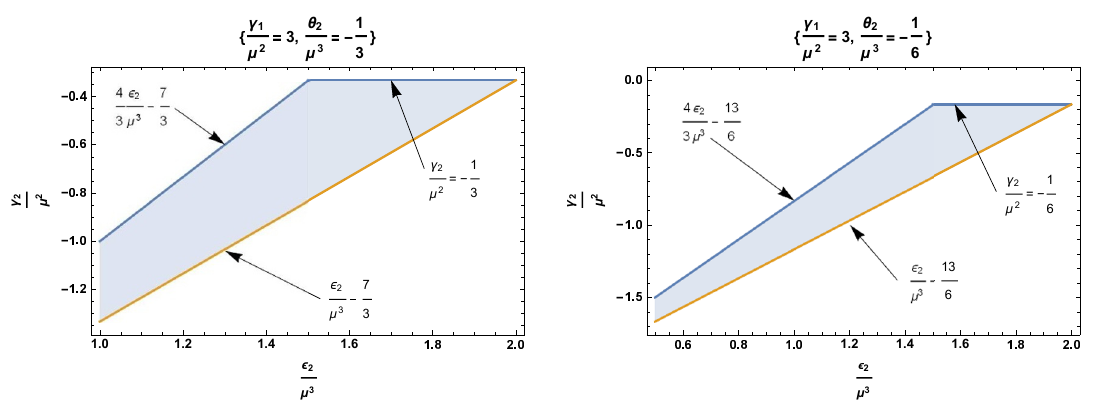
2 < ˜ θ 2 < 0. The right 2 and 3 ≥ − 3 ˜ θ 2 . −